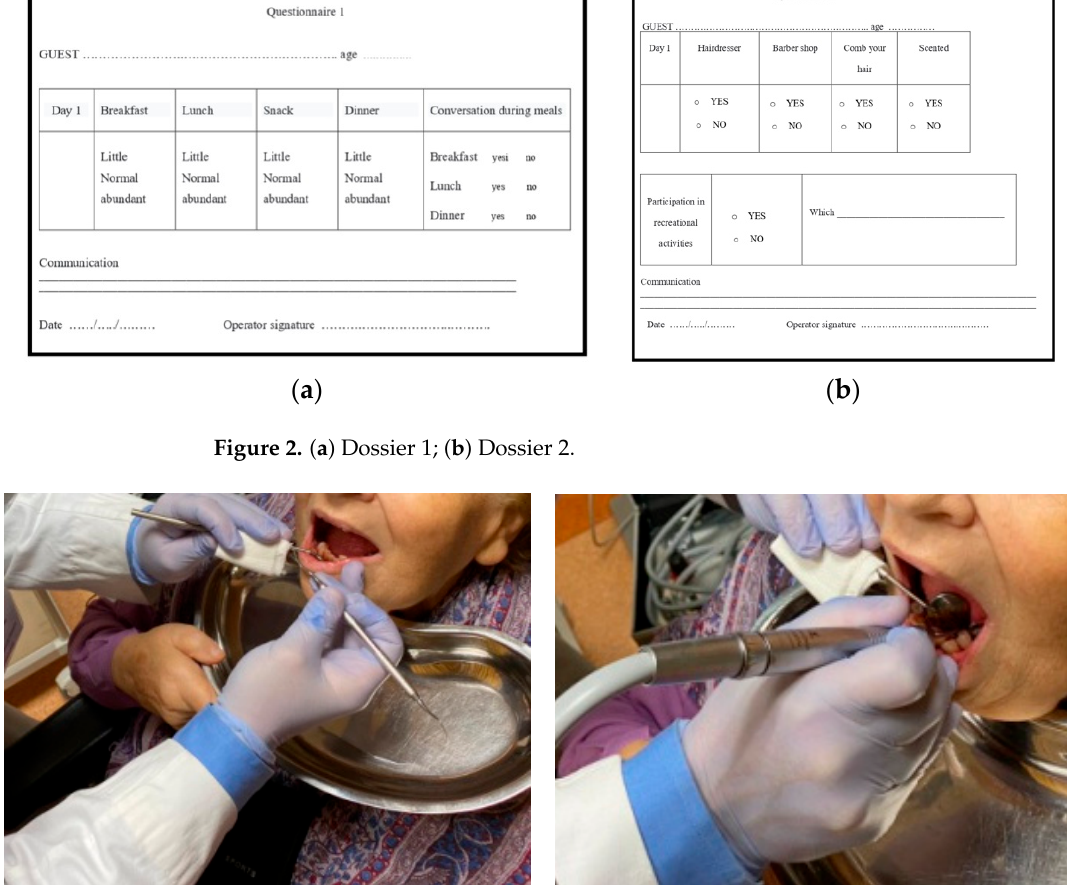
Figure 1. ( a ) Materials used for the study and relining impressions; ( b ) Portable unit complete with turbine, contra-angle, air-water syringe and saliva aspirator.